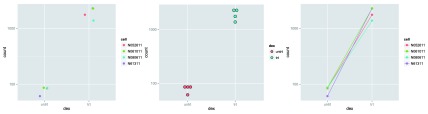
Normalized counts over treatment using different
ggplot2 styles.The plots are customized using
ggplot2 options for jitter (left), dots (middle), or with lines connecting cell line (right). Note that the
DESeq2 test that was used takes into account the cell line effect, so the rightmost figure more closely depicts the difference being tested.